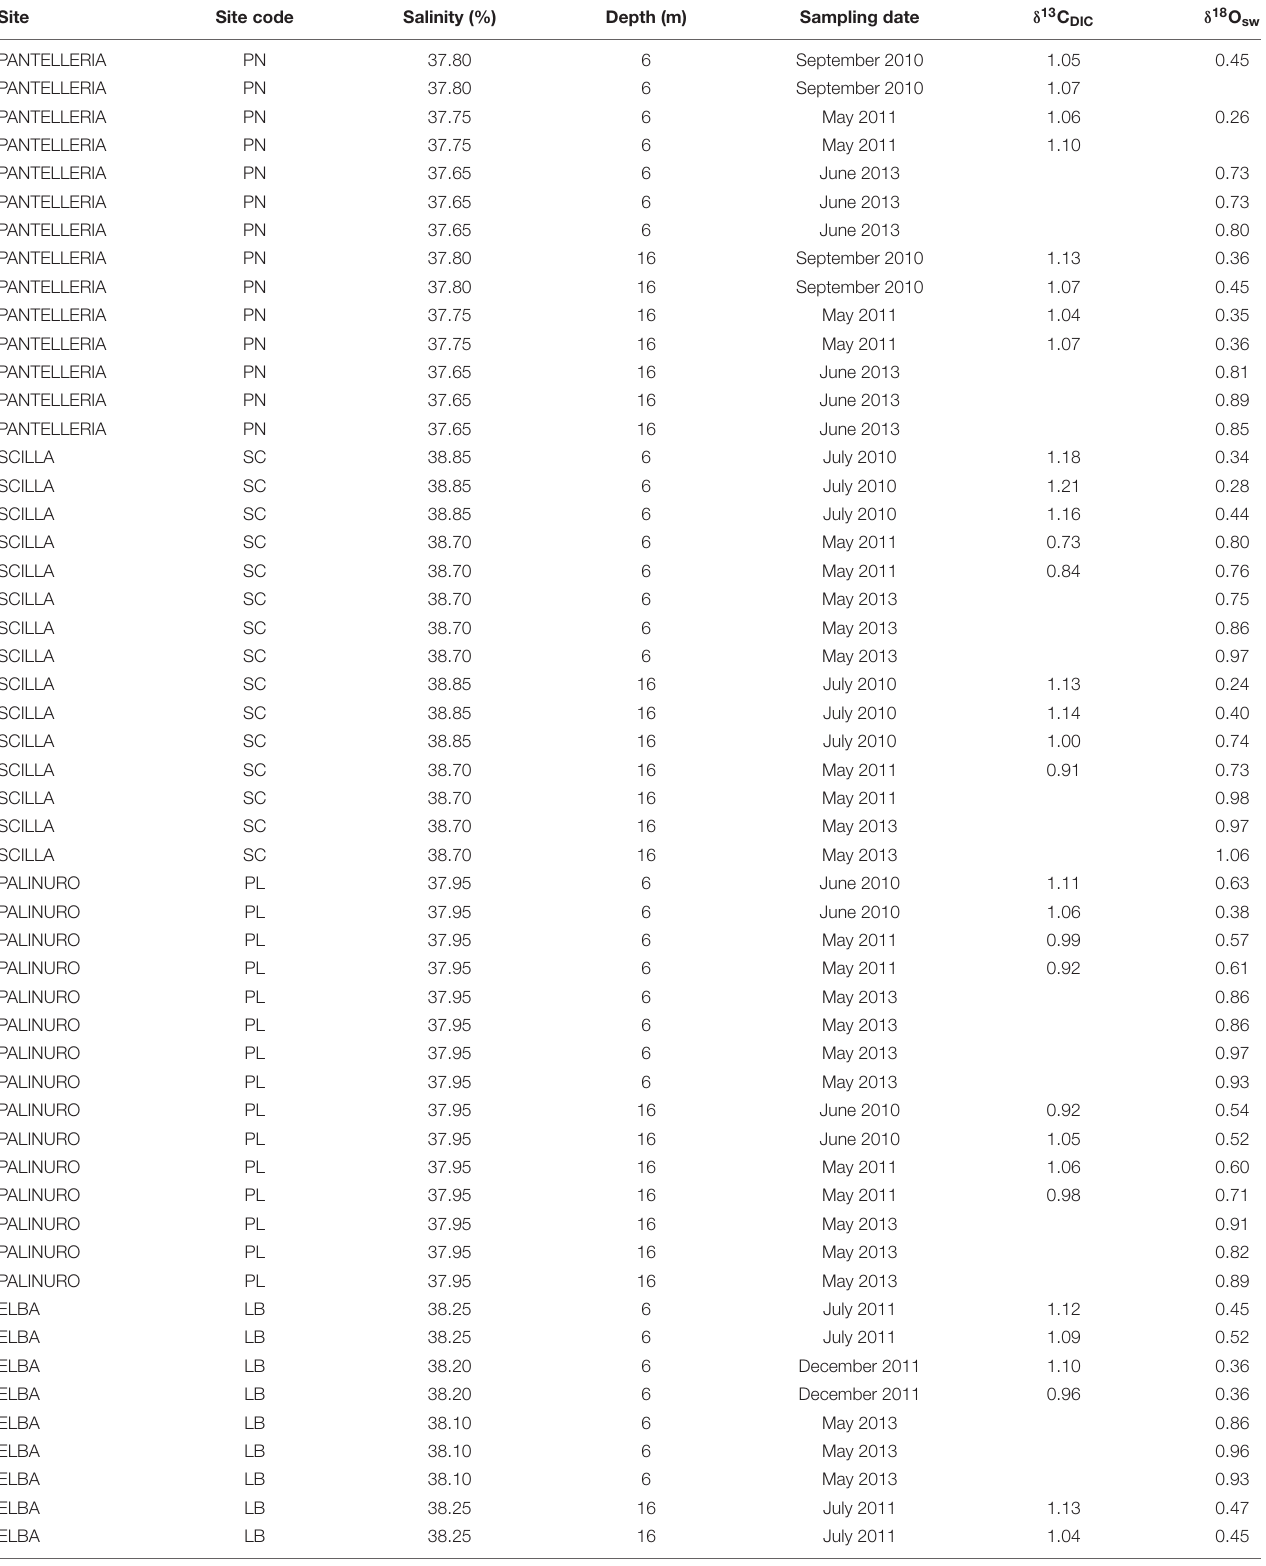
TABLE 3 | Seawater stable isotope data at 6 and 16 m depth in 6 sites along the west coast of Italy ( ∼ 850 km transect). Site Site code Salinity (%) Depth